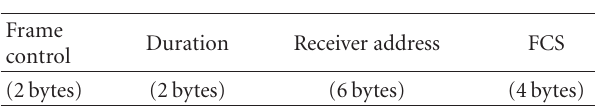
Table 4: ACK frame.